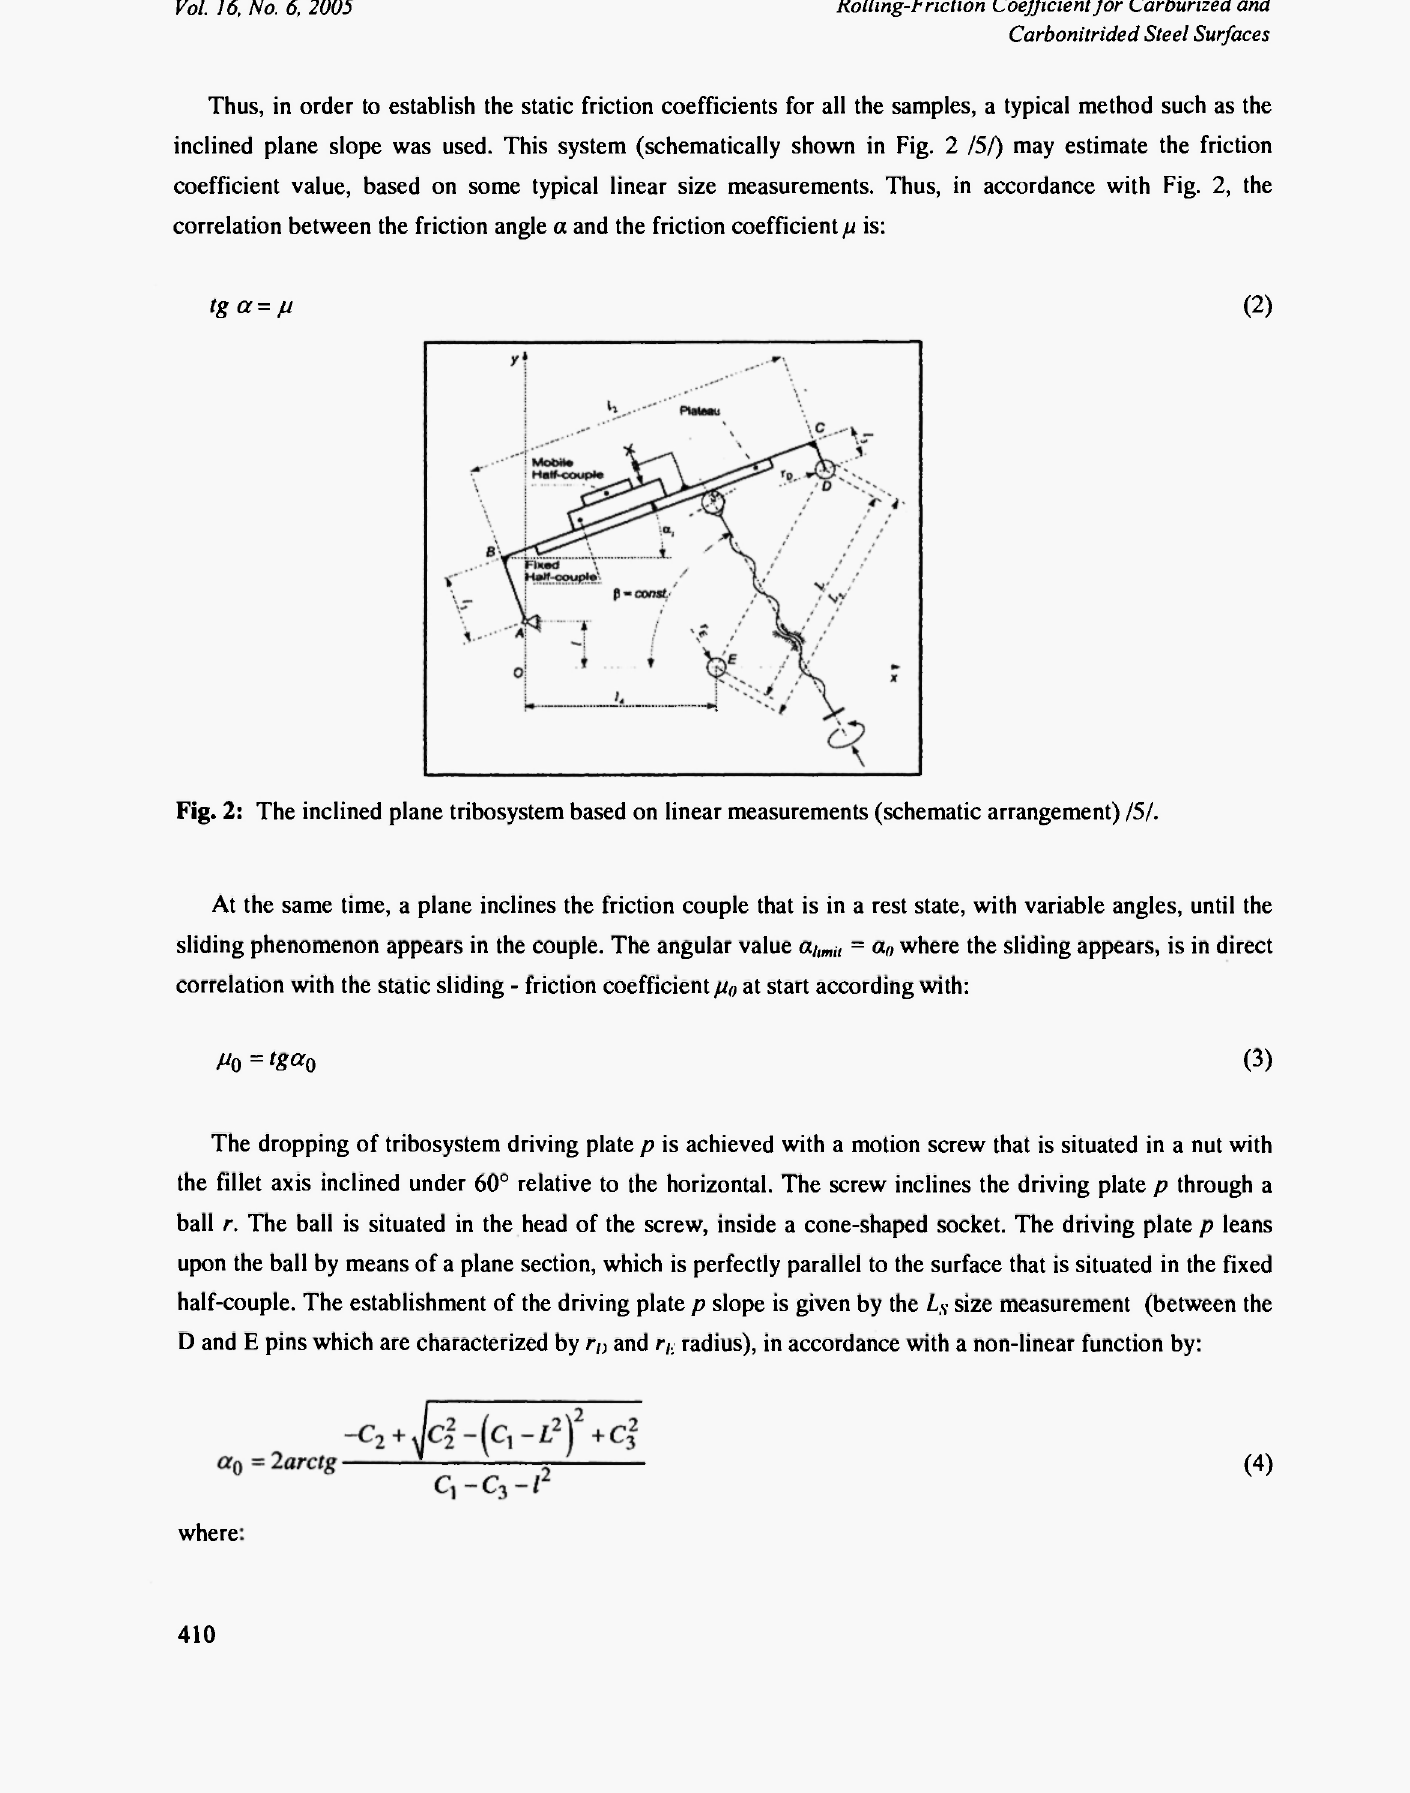
Fig. 2: The inclined plane tribosystem based on linear measurements (schematic arrangement) 151.